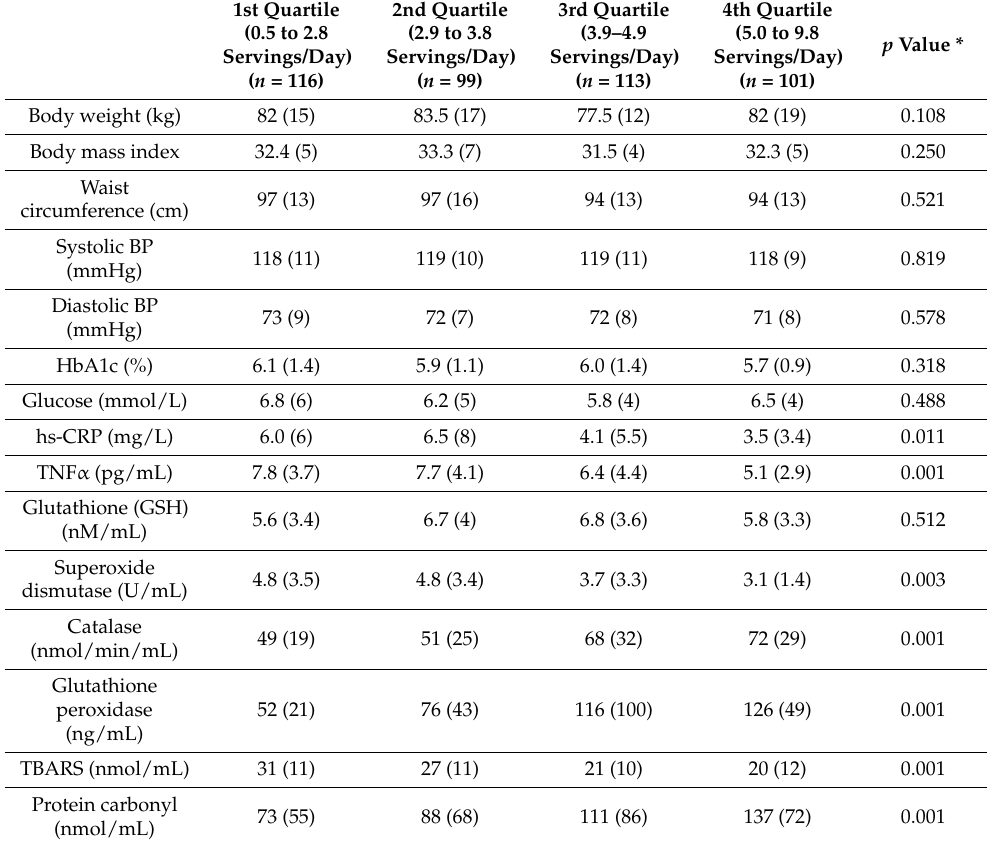
Table 3. Follow-up anthropometrics, BP, lipid contents, and inflammatory and oxidative damage markers according to fruit and vegetable consumption quartiles, mean